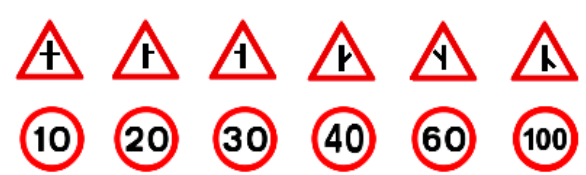
Figure 8: Difficult signs for classification.